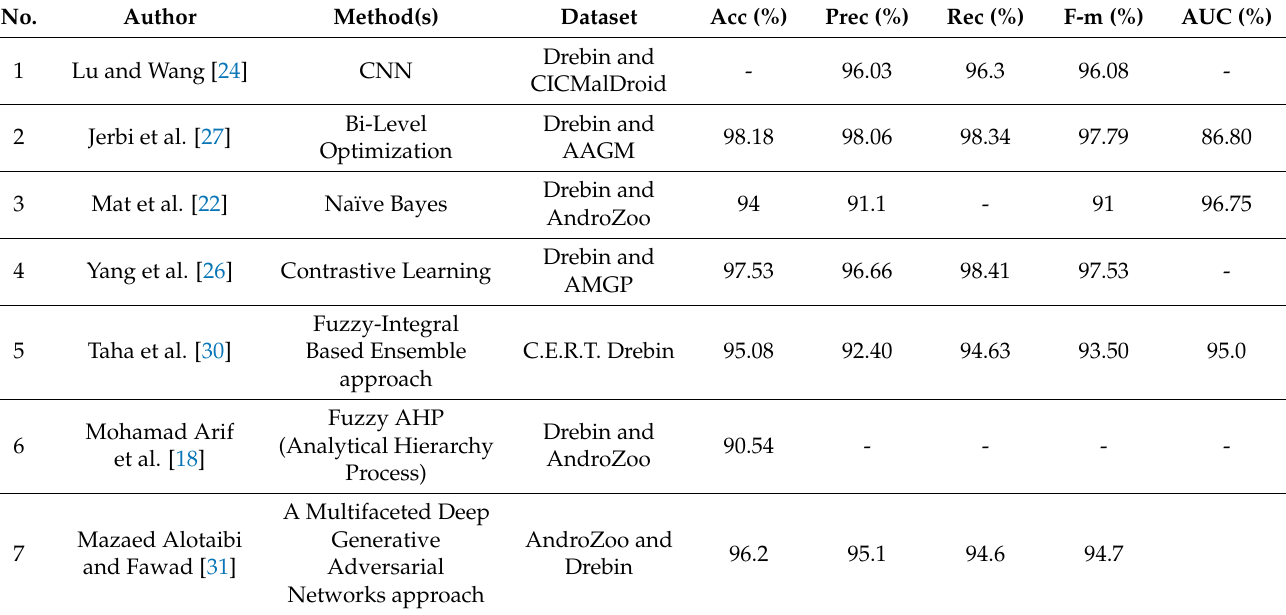
Table 5. A summary of the proposed model and the relevant studies in the literature and their performance